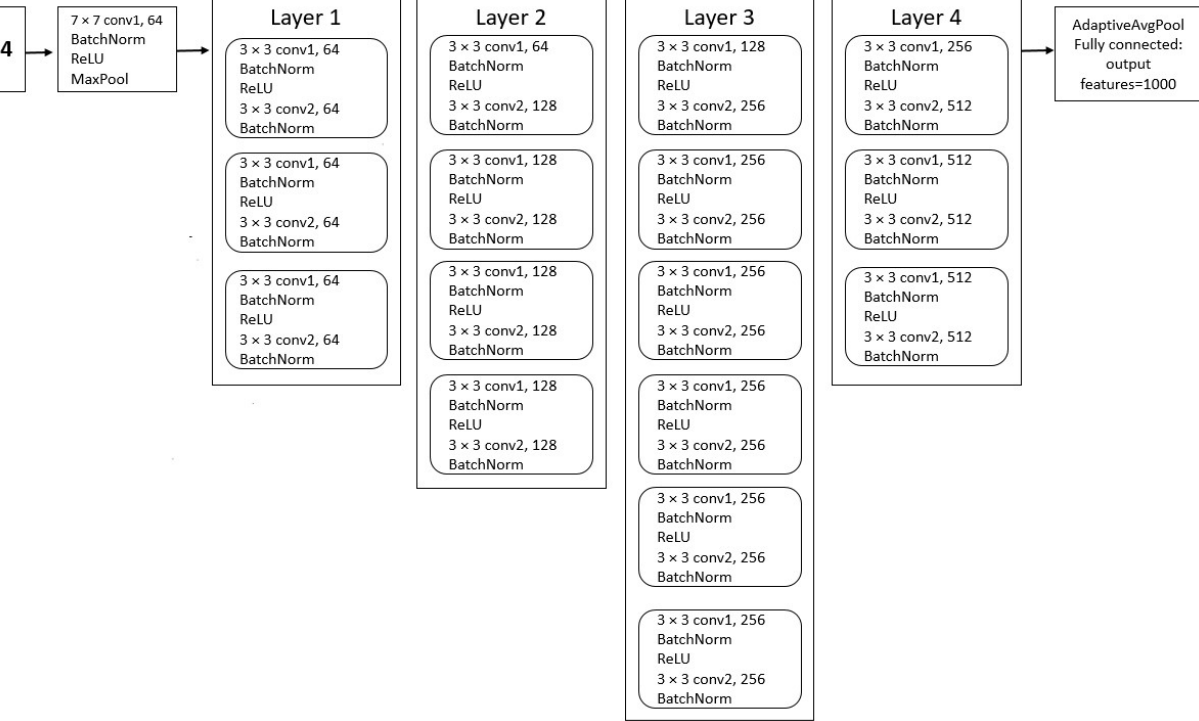
Figure 1. A schematic representation of Resnet34 architecture.